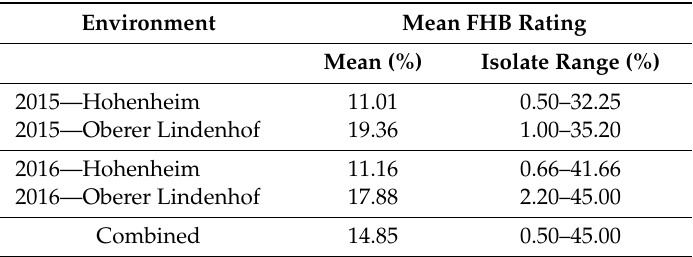
Table 3. Means and isolate ranges of mean Fusarium head blight (FHB) rating of rye after inoculation with 100 Fusarium culmorum isolates at two locations in two years (four environments).